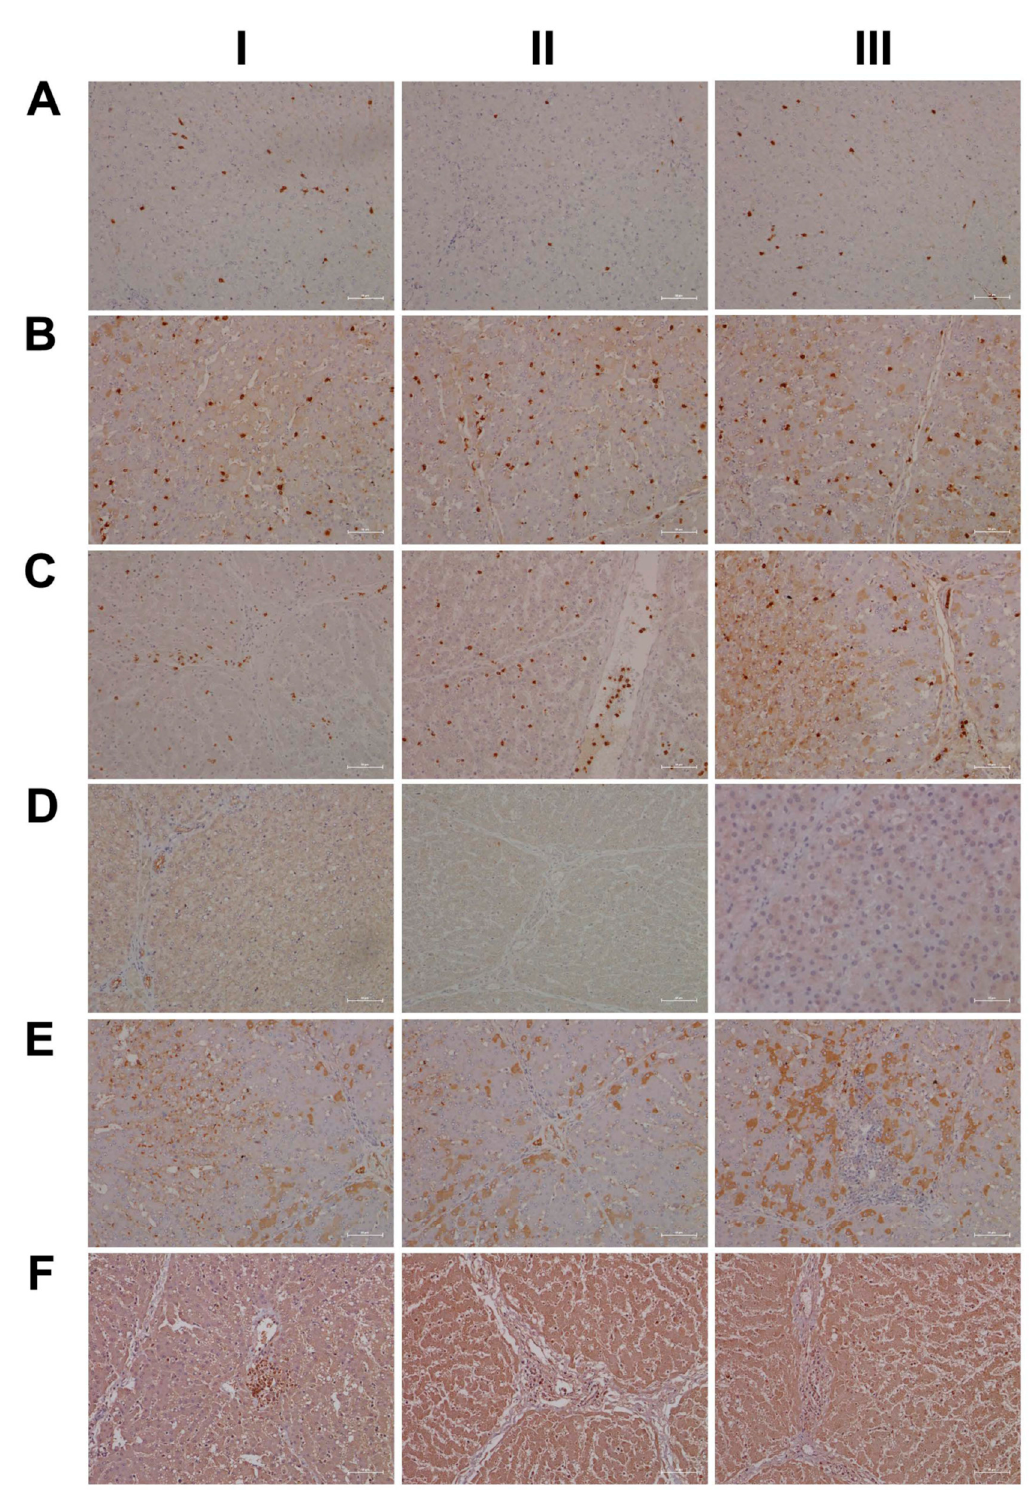
Figure 15. Immunohistochemistry of the liver clock components Per2 and CRY1 in liver sections of control and diclofenac-treated animals after daily dosing for 28 days. A complex relationship exists between the circadian clock and inflammation. Panel AI–III: Liver sections of three individual con- trol animals: Disseminated throughout the liver lobule are Per2-positive macrophages. Panel BI– III: Diclofenac low-dose treatment caused a marked increase in activated Per2-positive macro- phages. Some hepatocytes and sinusoidal endothelium also stained positive. Panel CI–III : High- dose diclofenac treatment. Hepatocytes of an inflamed liver lobule abundantly express Per2 (CIII).